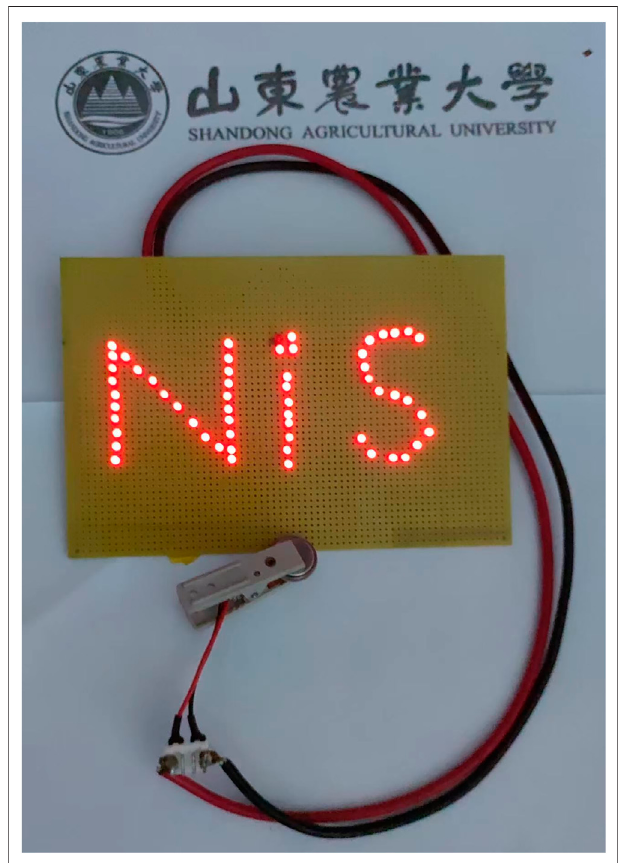
FIGURE 7 | The LED lamps of “ NiS ” illuminated by two cells in